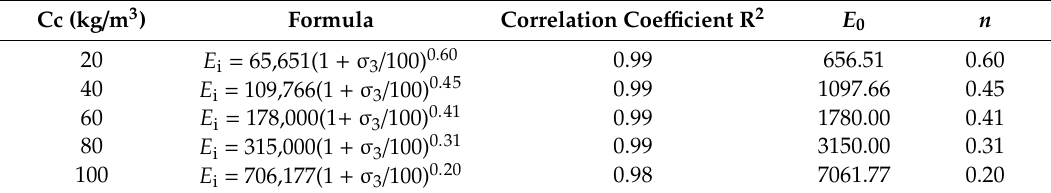
Figure 6. The relationship between the parameter E 0 and cement content Cc . Table 5. Values of R 2 , E 0 , and n .